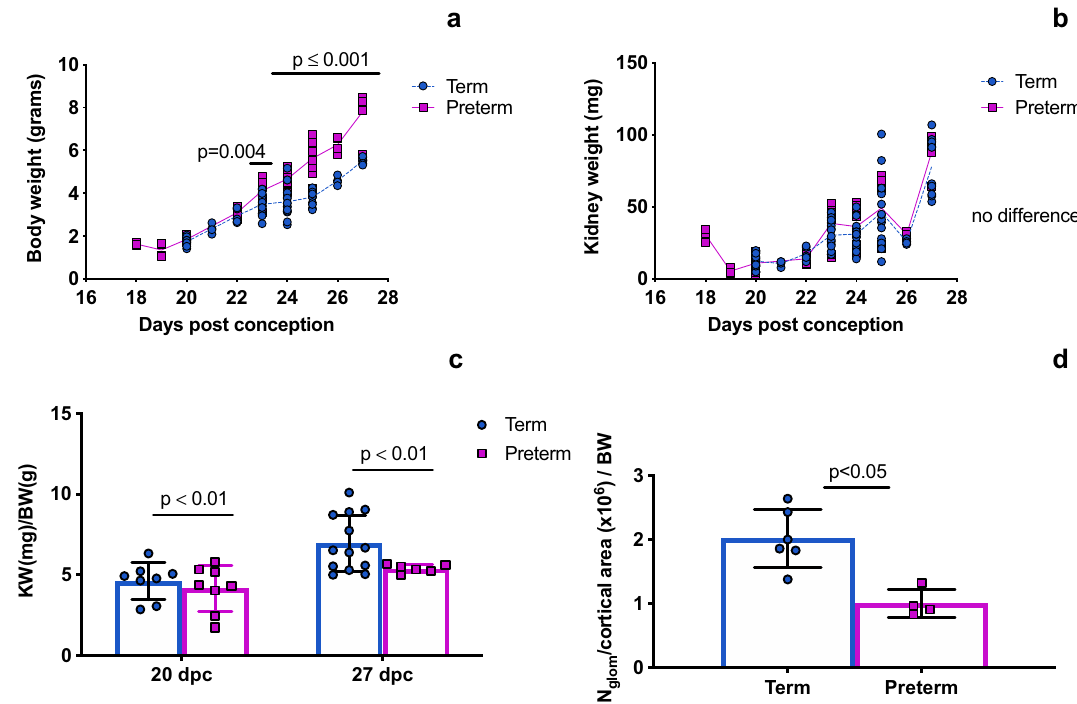
Figure 1. Body weight, kidney weight and glomerular density. Beginning at 23 dpc, the weight of the animals in the preterm group was greater than that of the term group ( a ). There was no difference in the absolute kidney weight between the preterm and term groups ( b ). When kidney weight was normalized to body weight, the preterm group had smaller kidneys at both 20 and 27 dpc ( c ). Glomerular density at 27 dpc was lower in the preterm group than in the term group ( d ). Data was analyzed using a t-test ( a , b ) and two-way ANOVA ( c ), Mann–Whitney test ( d ), with a p-value < 0.05 being considered statistically